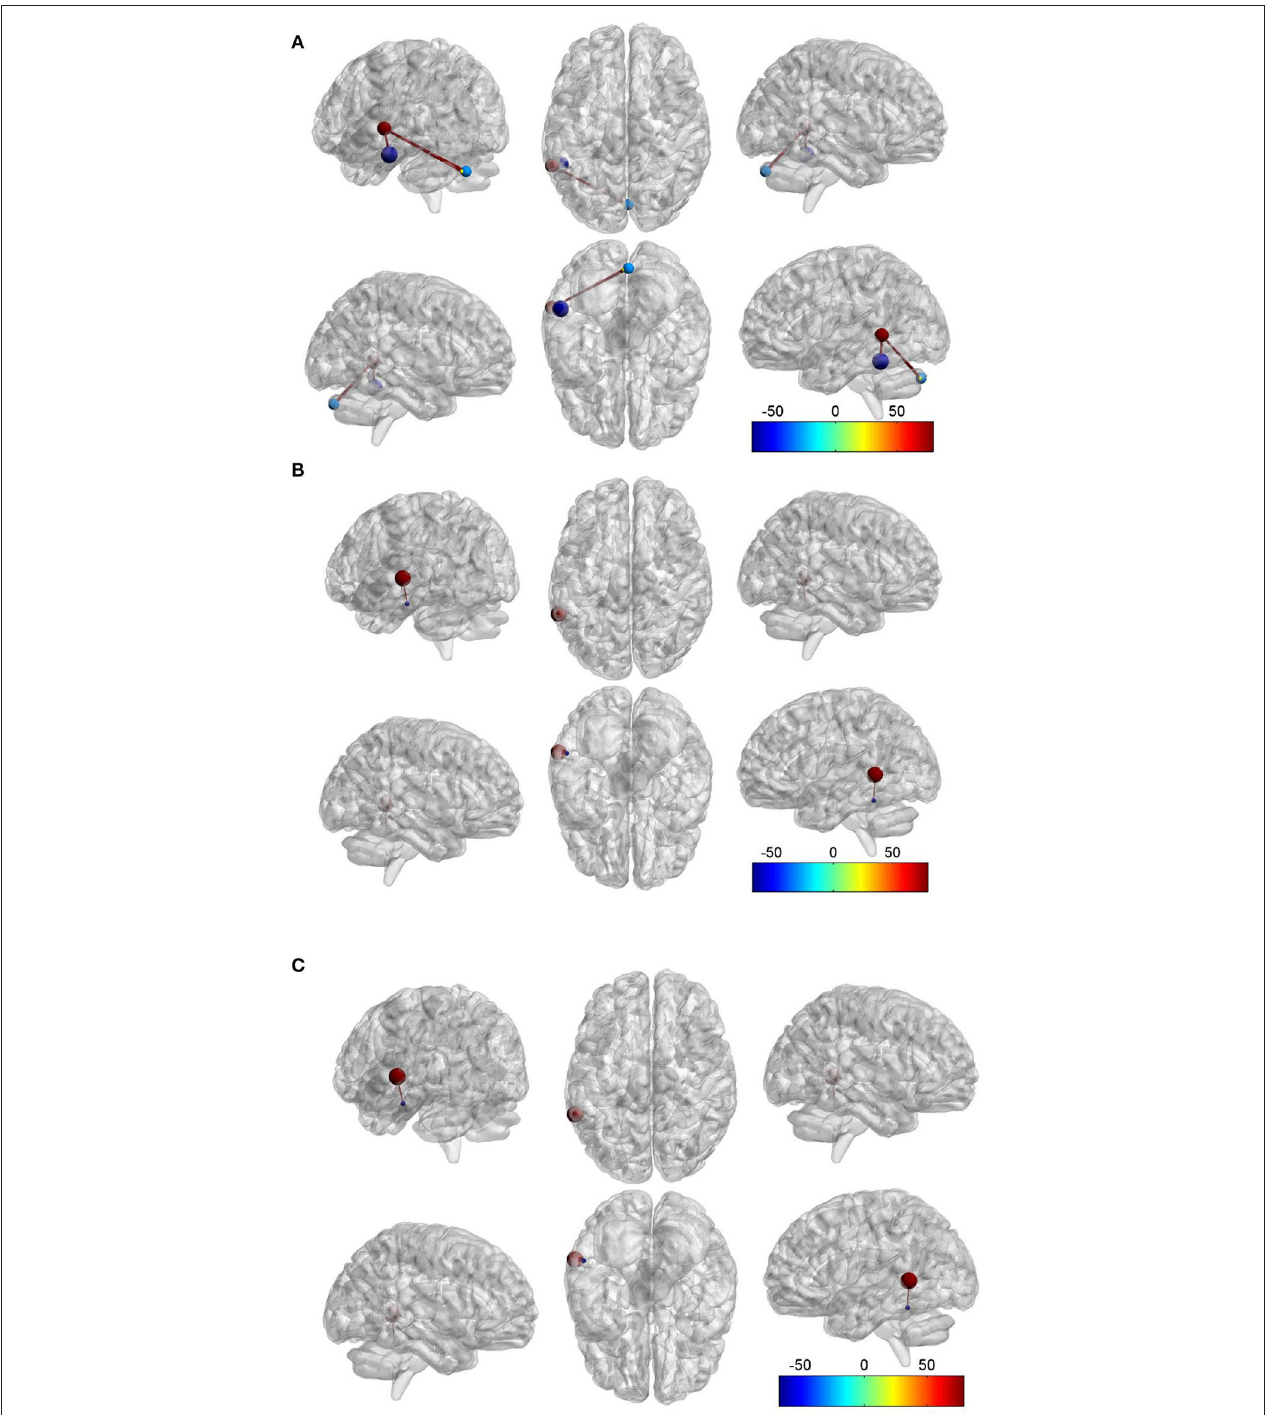
FIGURE 3 | Red ball. the left middle temporal gyrus (LMTG). Purple blue ball, the left inferior temporal gyrus (LITG). Light blue ball, the right cerebellum. Yellow ball, the left cerebellum. Red bar, functional connectivity (FC). (A) Compared to the HC group, we found that there was FC between the LMTG and LITG in the TLEIP group, we also found that there were FCs between the LMTG and cerebellum (both left and right) in the TLEIP group. (B) Compared to the TLE without IP group, we found that there was FC between the LMTG and LITG in the TLEIP group. (C) Compared to the HC group, we found that there was FC between the LMTG and LITG in the TLE without IP group but the area of the LITG in the TLEIP vs. HC group was larger than those in the TLE group vs. HC group. In addition, the difference in the magnitude of FC between the TLEIP vs. HC group was greater than the difference between the TLE without IP vs. HC group. (GRF correction, two-tailed, voxel level P < 0.001, cluster level P <